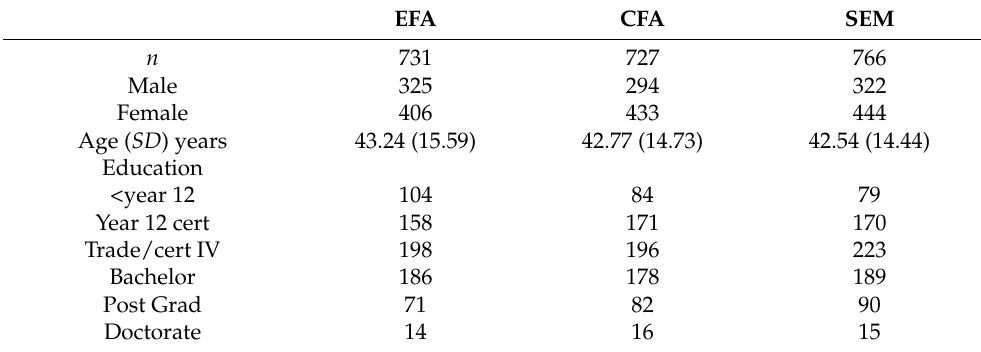
Table 2. Descriptive statistics for each of the datasets by analysis type.